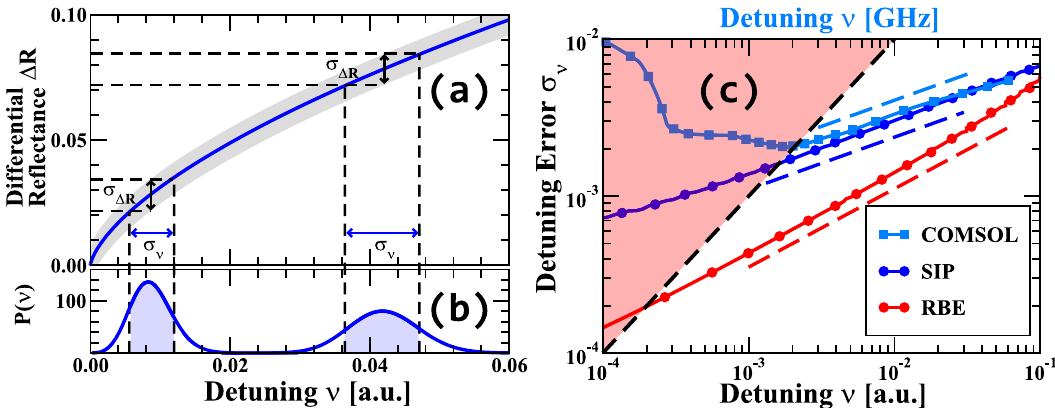
Fig. 5 Monte-Carlo precision measurements in case of input signal amplitude noise. a The differential re fl ectance Δ R as a function of the detuning ν . Height of the gray domain represents the evaluated standard deviation σ Δ R in the measured differential re fl ectance for each value ν of the frequency detuning. b Probability density of the detuning measurements P ð ν Þ under the in fl uence of input signal noise for two distant values of ν . The blue double- sided arrows indicate the corresponding standard deviations for the extracted ν . c Calculated detuning error σ ν as a function of the frequency detuning ν from the ω SP in case of a stationary-in fl ection-point-based sensor (blue line with circles), in case of a regular-band-edge-based sensor (red line with circles), and in the case of the COMSOL simulated stationary-in fl ection-point-based sensor shown in Fig. 1e (light-blue line with squares). The dashed blue and light-blue lines indicate a scaling ν j j 1 = 3 , while red dashed line indicates a scaling ν j j 1 = 2 . The variance of the input signal noise in the Coupled Mode Theory Monte-Carlo simulations is σ 2 ¼ 10 (cid:5) 5 , while for the COMSOL simulations σ 2 ¼ 5 ´ 10 (cid:5) 4 þ þ